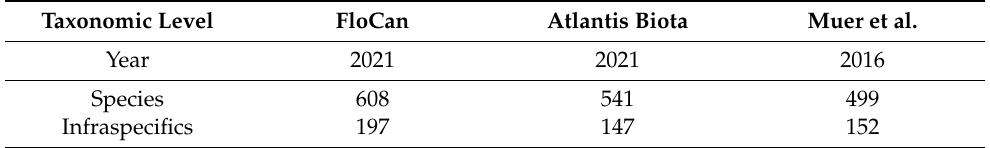
Table 2. Numbers of endemic species and endemic infraspecific taxa (subspecies, varieties) in current plant lists of the Canary Island archipelago.